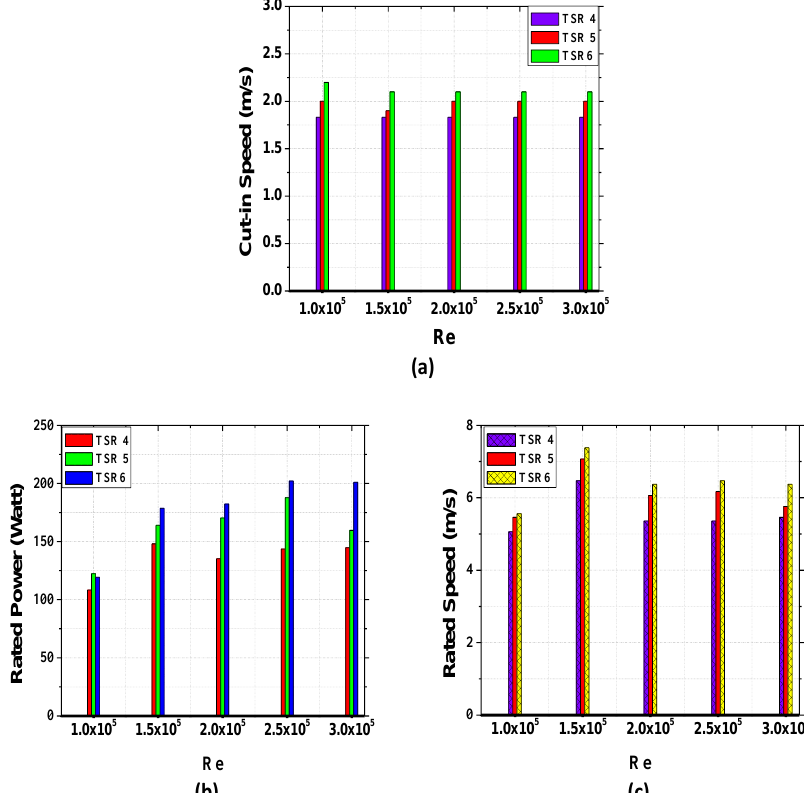
Figure 18. ( a ) Cut-in speeds; ( b ) Rated powers; ( c ) Rated speeds for NACA 4412 rotor blades.